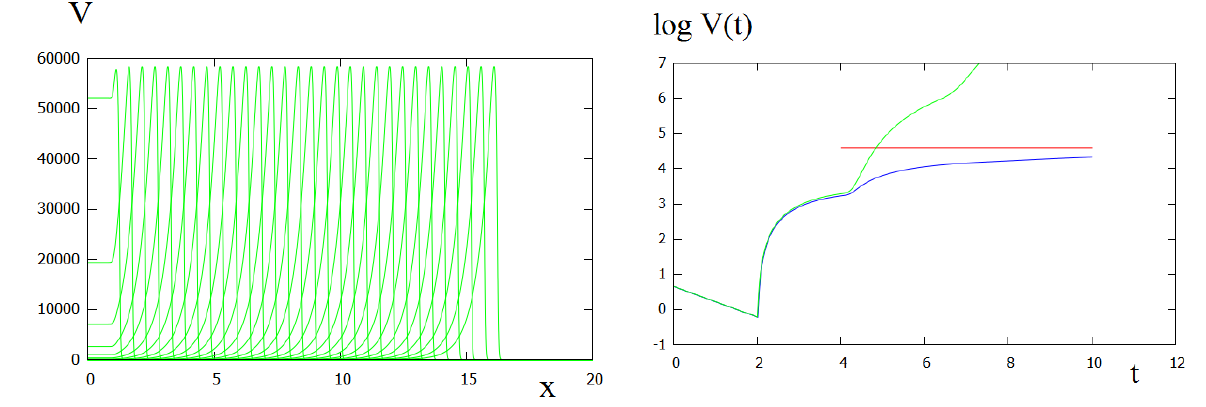
Figure 3. Left : virus distribution in consecutive moments of time (every 1 h). Right : total viral load (cid:82) L W ( t ) = V ( x , t ) dx (in the logarithmic scale) found as solution of system (64), (65) (green), of system 0 (11)–(13) (blue) and by the formula in Theorem 1 (red). The values of parameters: a = 0.01, b = 8 × 10 4 , D = 10 − 3 , β = 0.1, σ = 1, τ = 2.